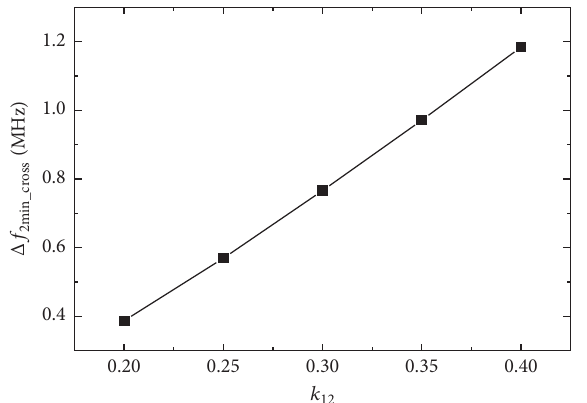
Figure 11: The influence of 𝑘 12 on the value of Δ𝑓 2 min